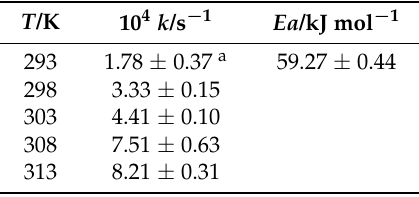
Table 1. The rate coefficients and the activation energy for the solid-state dimerization of the p -bromonitrosobenzene after sublimation ( T —temperature, Ea —activation energy, k —rate